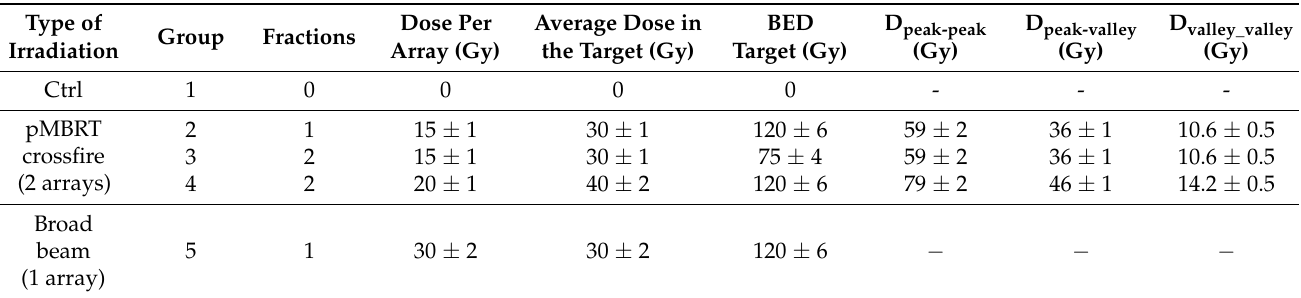
Table 1. Group distributions and